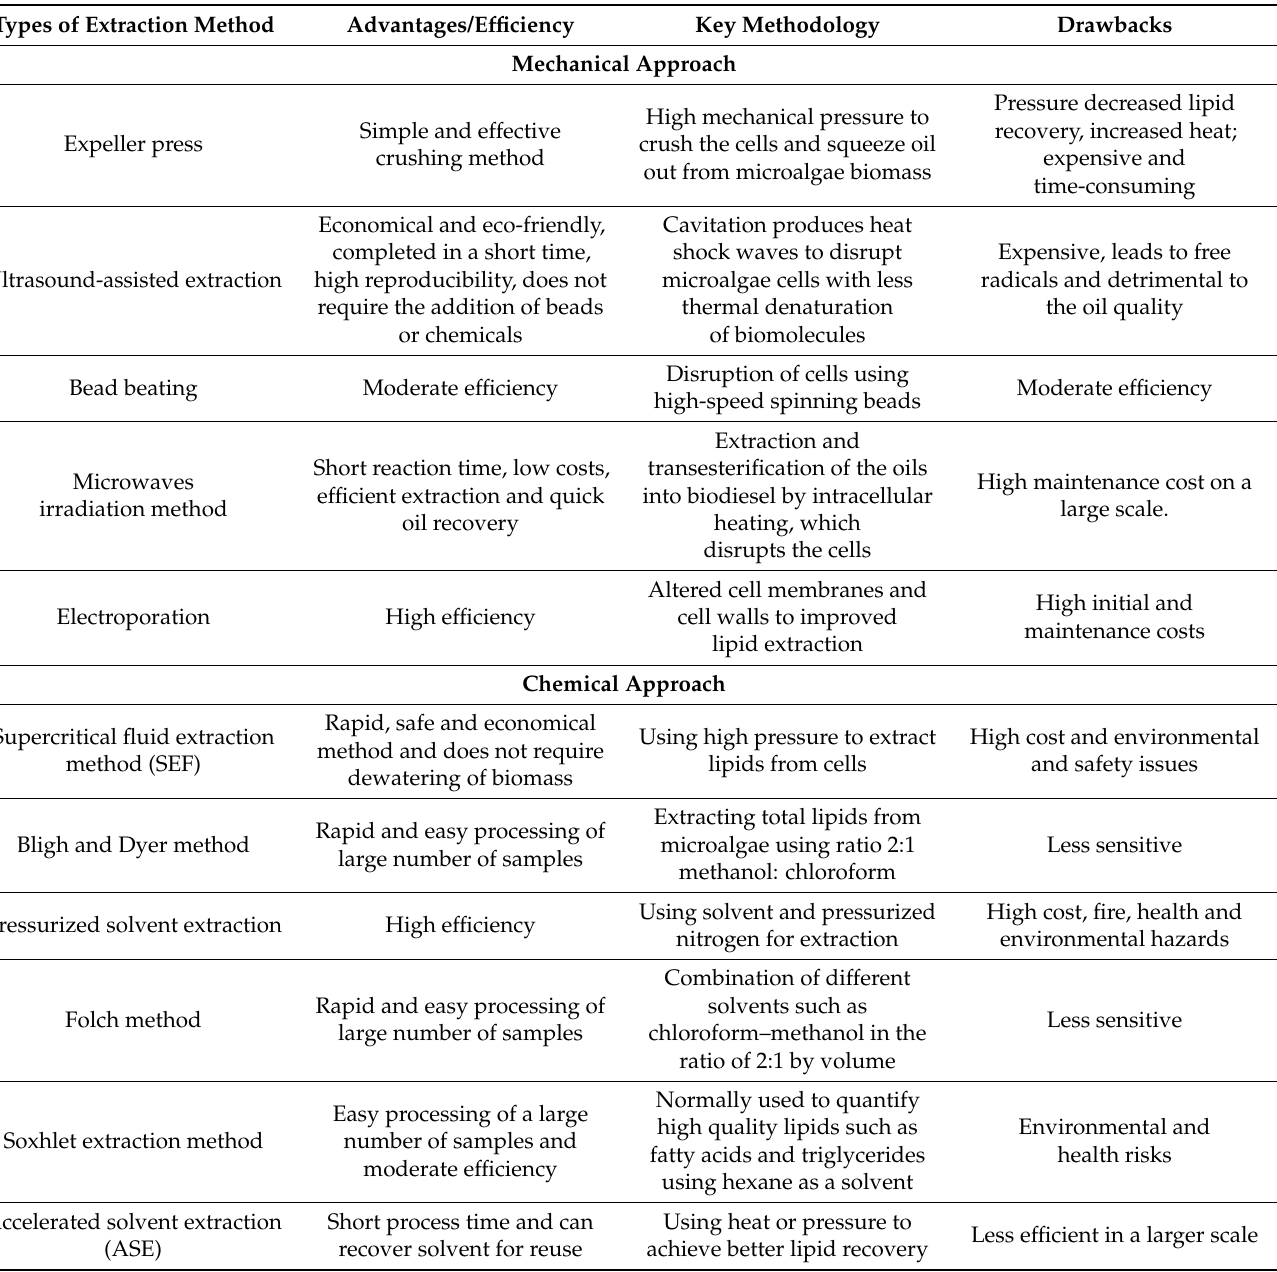
Table 5. Techniques used to quantify lipids in microalgae